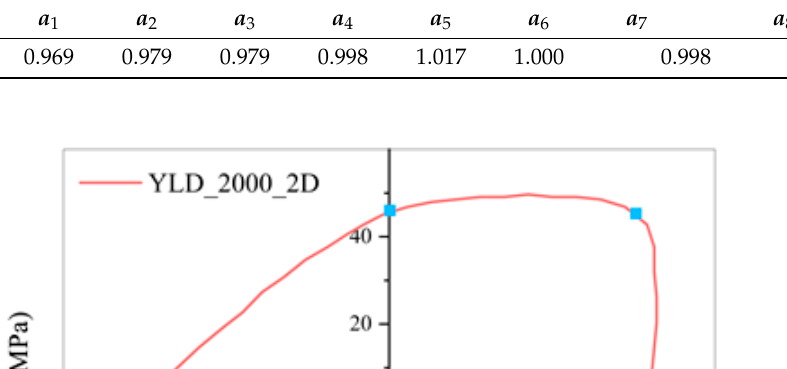
The eight parameters of YLD2000-2D yield model obtained by minimum error func- tion method are shown in Table 3. The yield trajectory of YLD2000-2D model is shown in Table 3. YLD2000-2d yield criterion parameters of 7075 aluminum alloy. Figure 4. Table 3. YLD2000-2d yield criterion parameters of 7075 aluminum alloy.